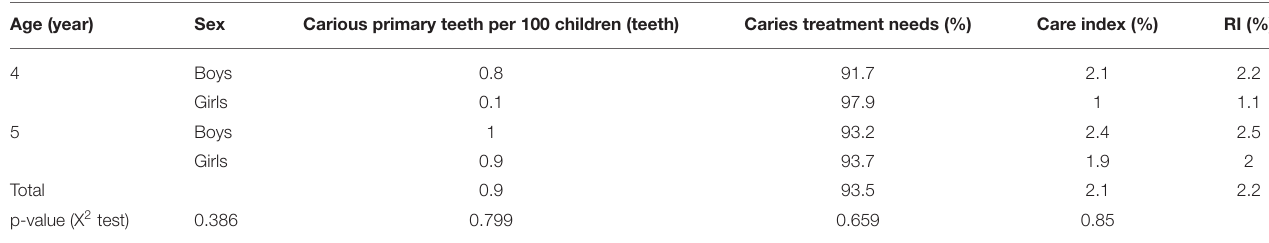
TABLE 2 | The distribution of different indices of 1,156 children by age and